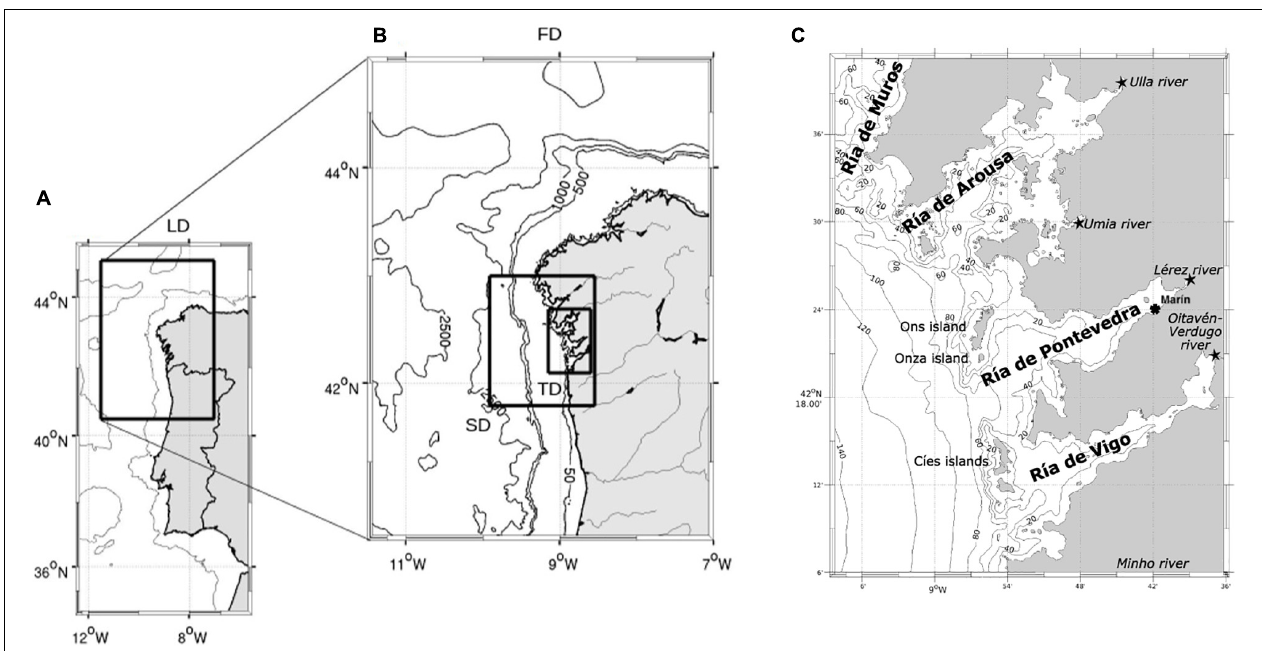
FIGURE 1 | Geographic location of (A) the large (LD), (B) first (FD), second (SD), and third (TD) domains. The FD shows the 50, 500, 1,000, and 2,500 m bathymetric contours. (C) Map of Galician Rias Baixas with isobaths at 20 m intervals, NW of Iberian Peninsula, with names of Rias, main tributary rivers, islands, and (black asterisk) Marín location at the Ría de